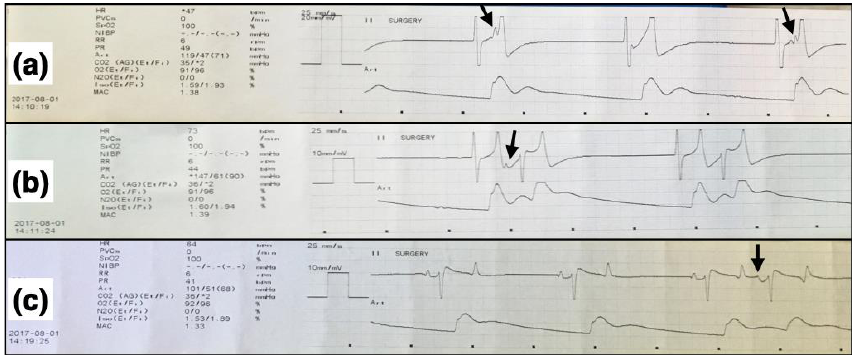
and 6 in panel ( d ) were already receiving dobutamine at the first recording of mean arterial pressure.